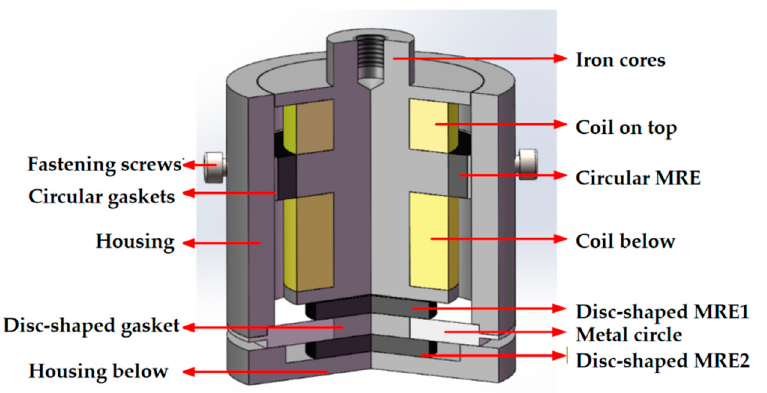
Figure 5. Composite bidirectional MRE vibration isolators.